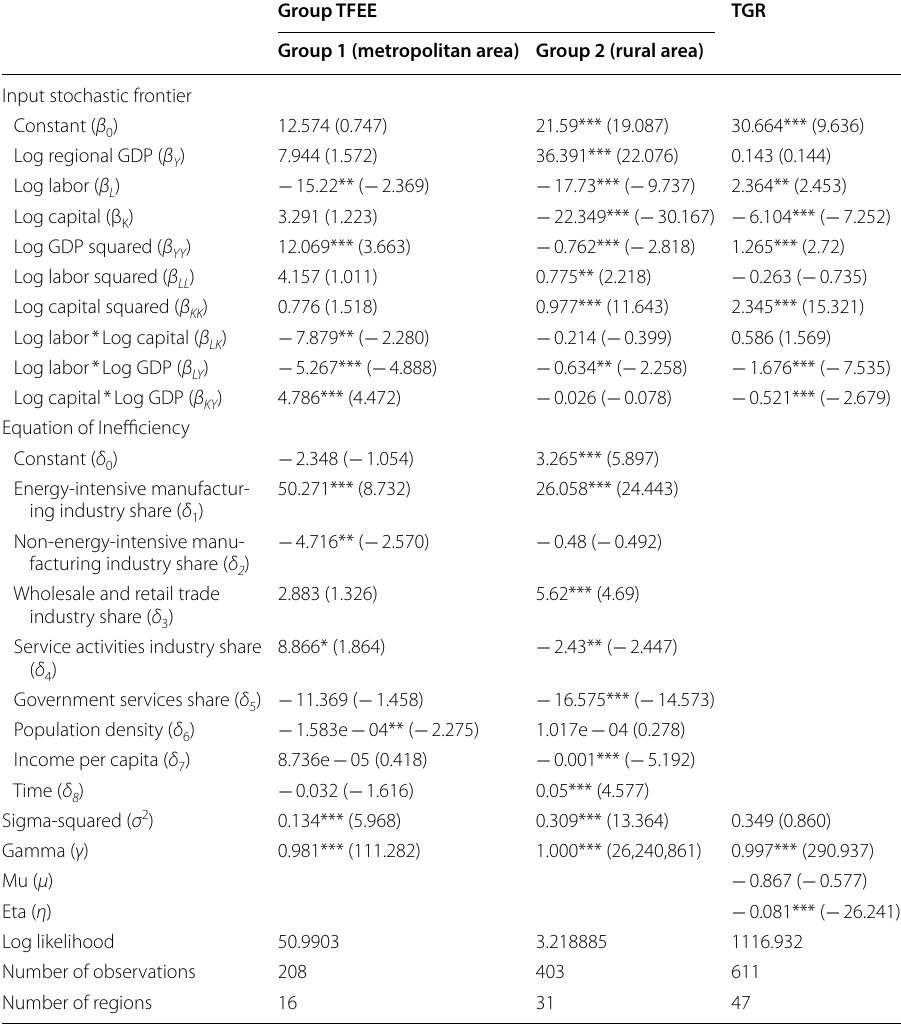
Table 2 ML estimates of efficiency and its